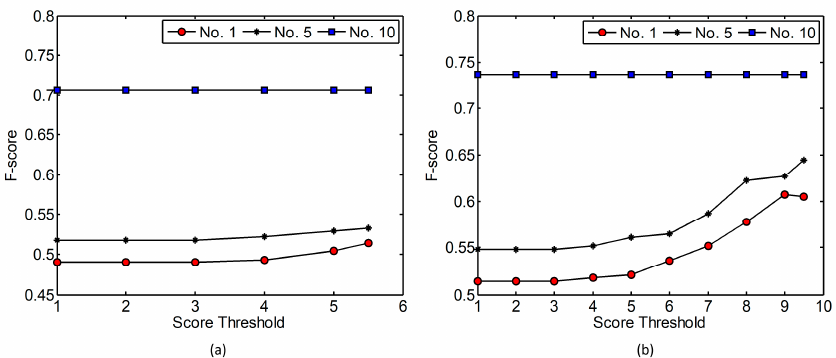
Figure 11. The effects caused by changing score threshold on test site 1: ( a ) MaxD = 1.0 m, significance level = 0.10; ( b ) MaxD = 1.5 m, significance level = 0.10. The 1st, 5th, and 10th combinations in Table 2 were applied.